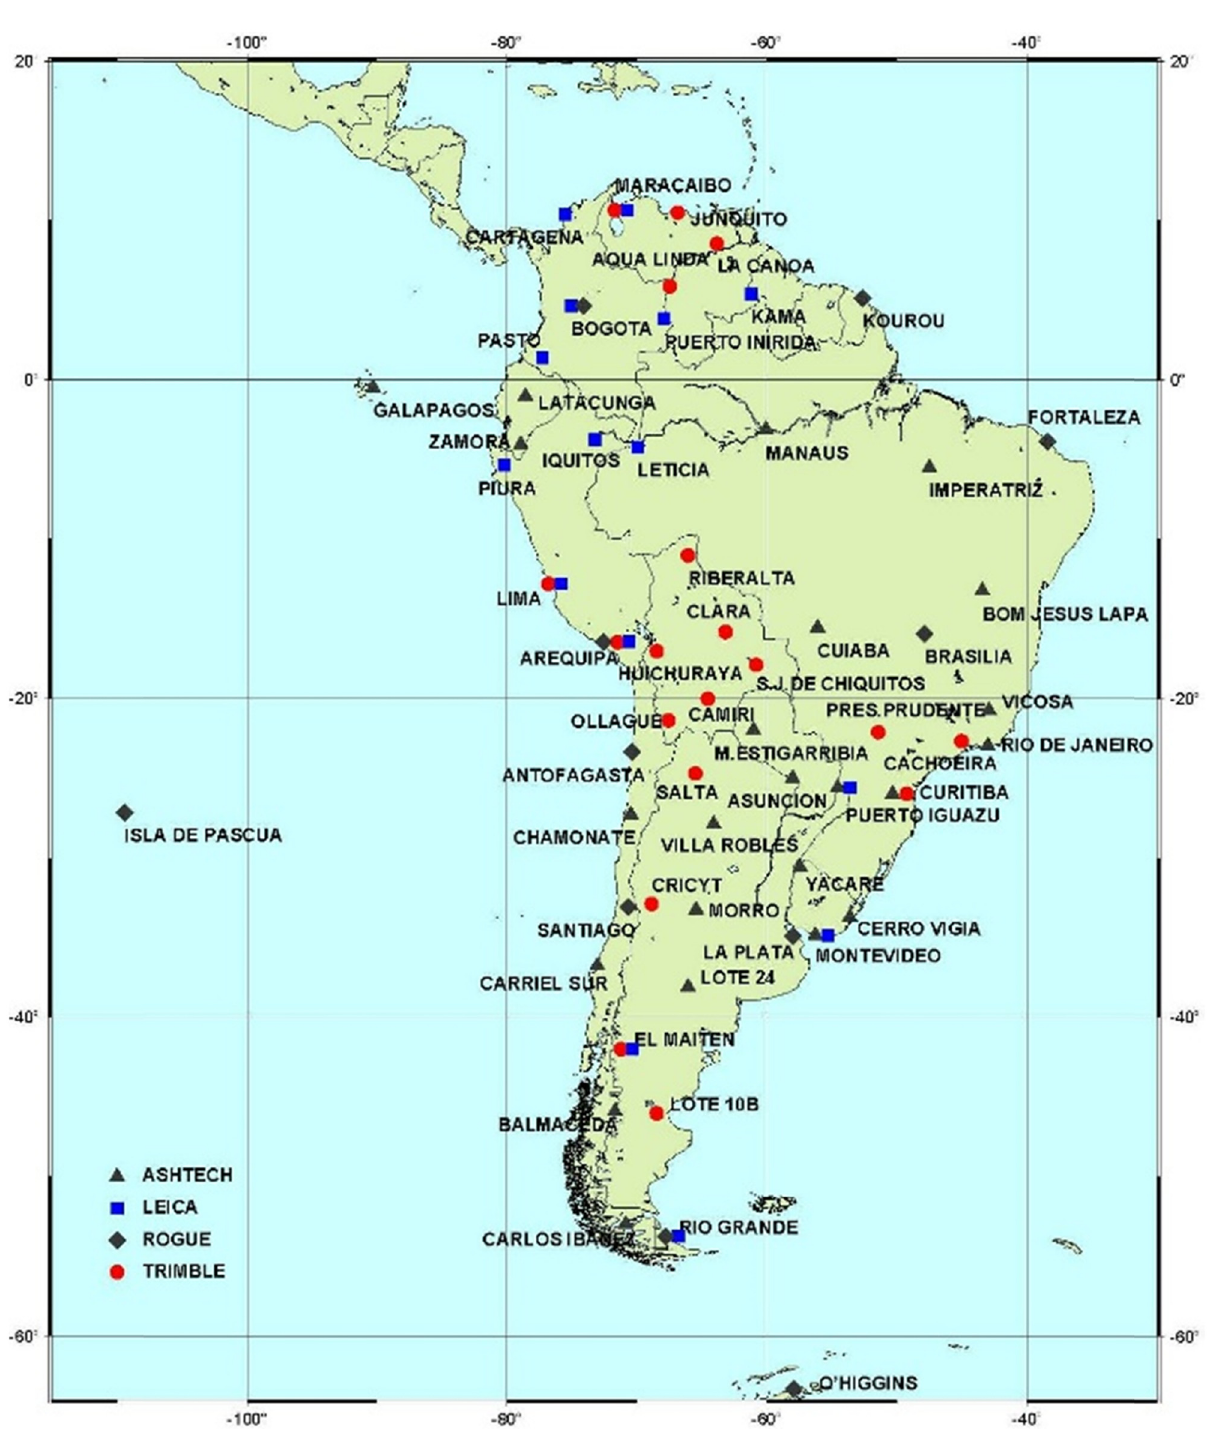
Figure 3: SIRGAS 1995 reference frame with four employed receiver